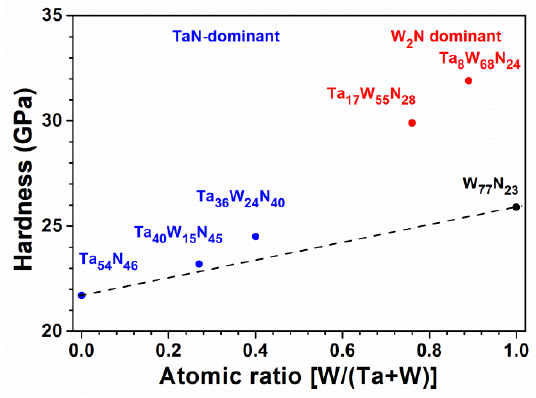
Figure 9. Hardness values of the TaWN films.